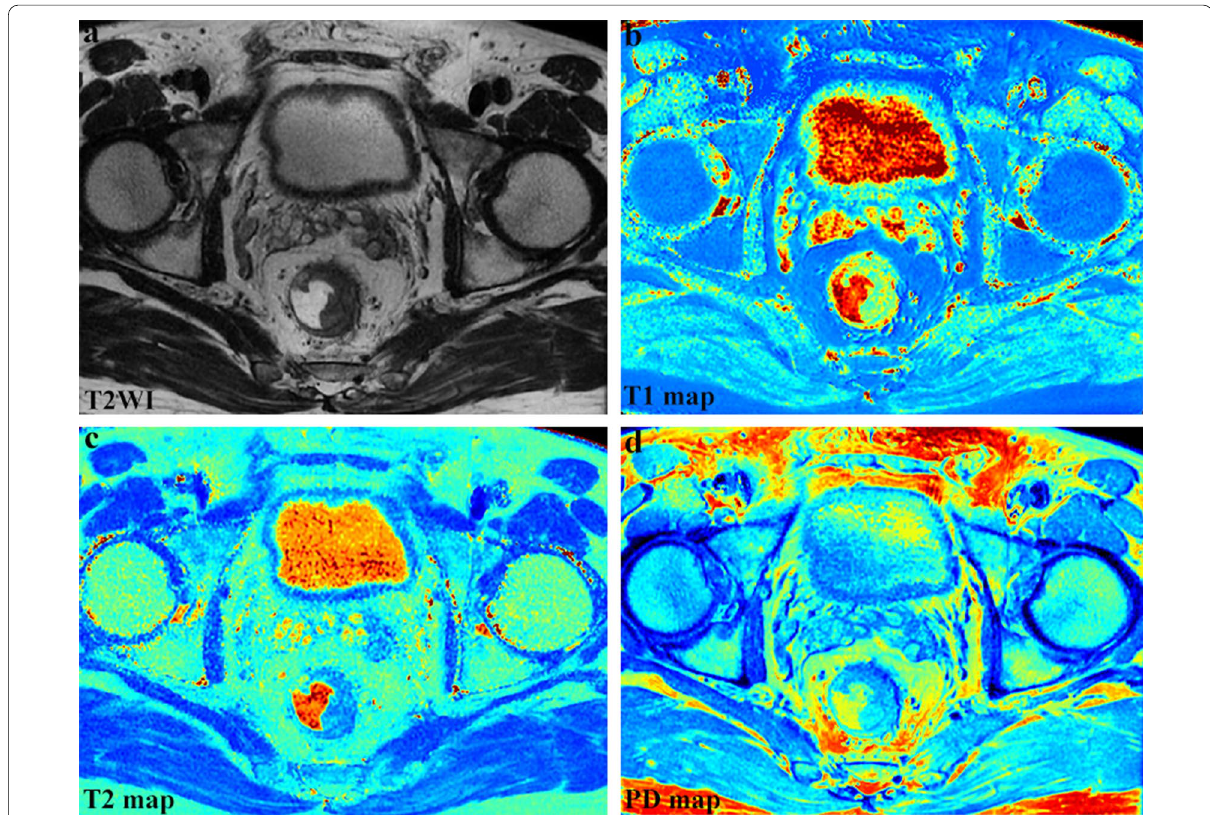
Fig. 2 Representative synthetic magnetic resonance images from a 57‑year‑old male patient with rectal cancer. ( a – d ) T2‑weighted imaging (T2WI), T1 map, T2 map, and PD